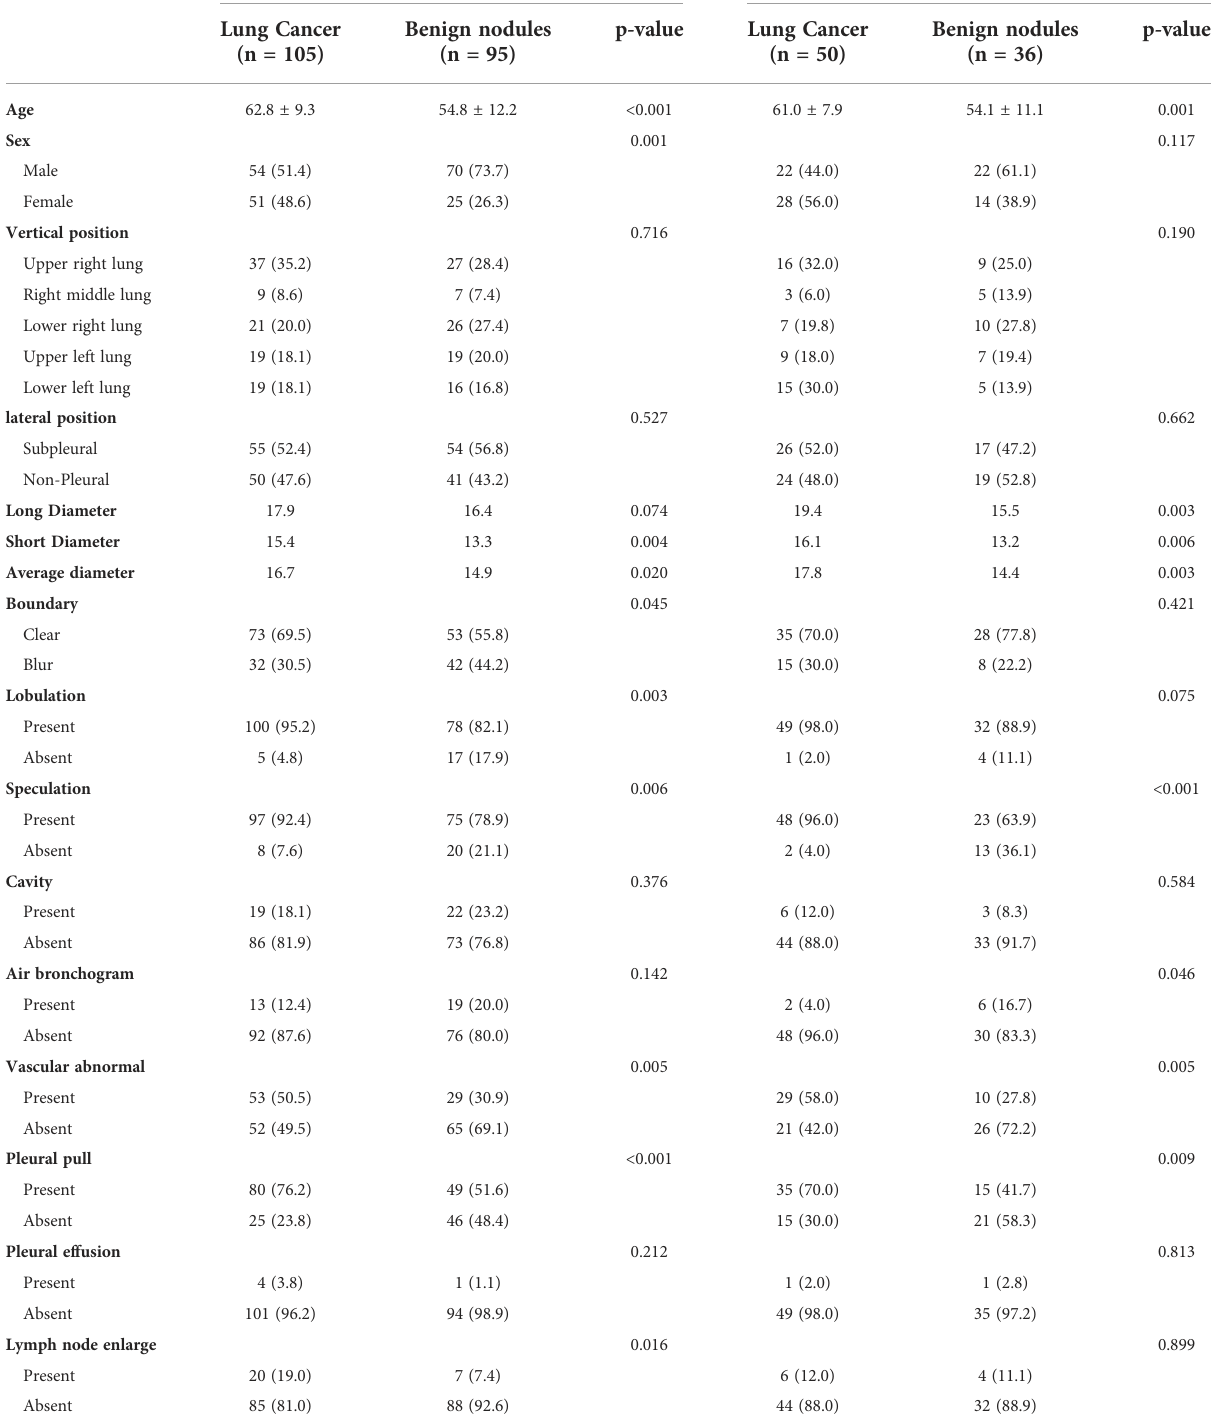
TABLE 1 Clinical-radiological performance of patients in the training and validation